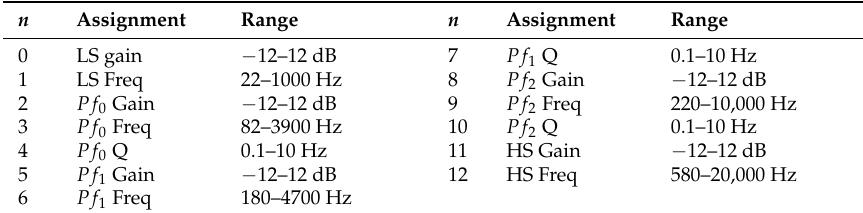
Table 1. A list of the parameter space variables and their ranges of possible values, taken from the Semantic Audio Feature Extraction (SAFE) parametric equaliser